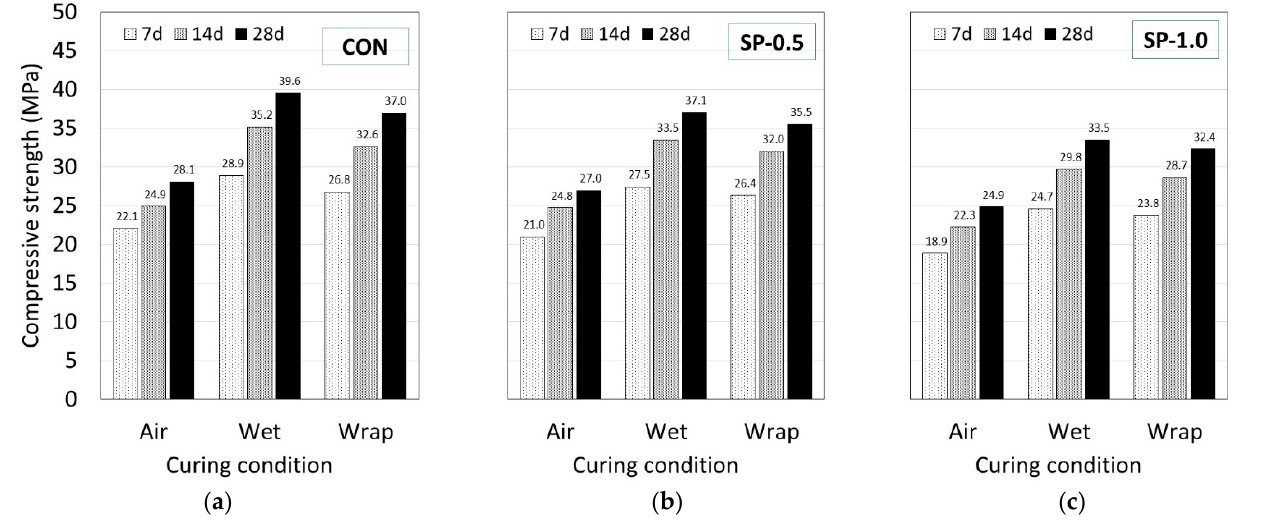
Figure 4. Compressive strength of ( a ) CON, ( b ) SP-0.5, and ( c ) SP-1.0 at different curing